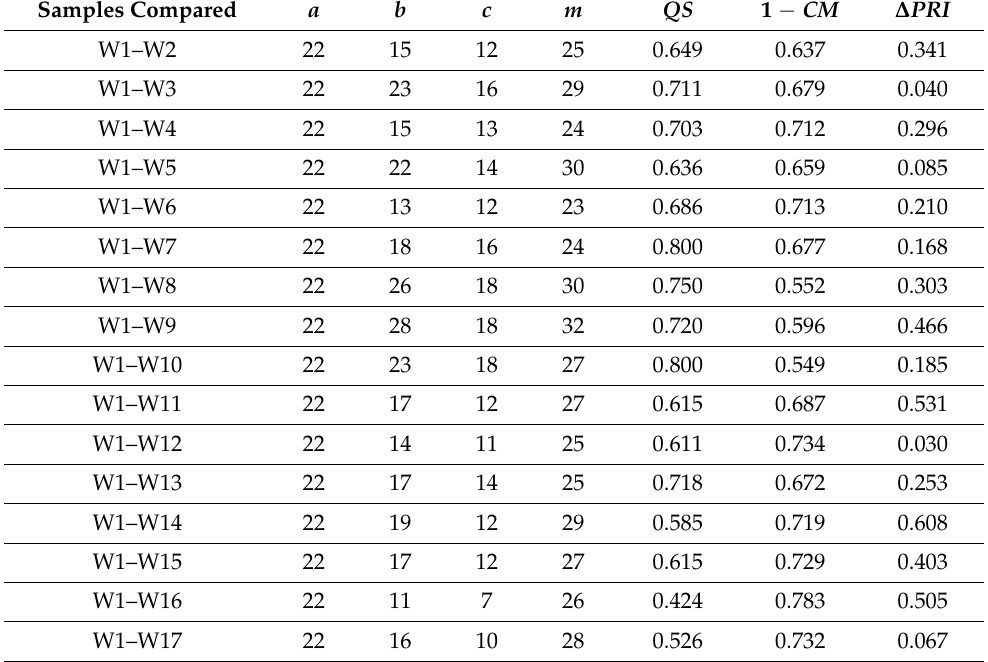
Table A1. Data supporting the case study